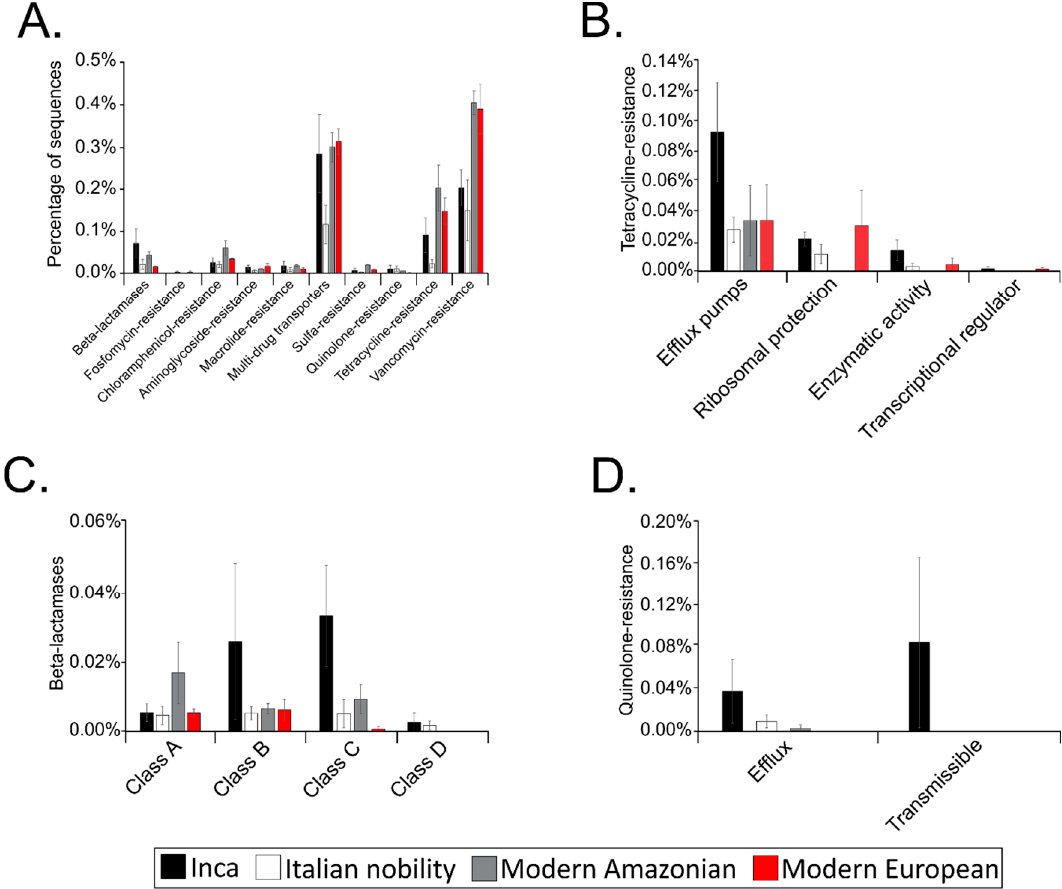
Figure 5. Putative resistome profiles of the pre-Inca/Inca and Italian nobility mummies. ( A ) Percentage of sequences similar to genes encoding for putative β -lactamases, multidrug transporters and resistance to fosfomycin, chloramphenicol, aminoglycoside, macrolide, sulfa, quinolone, tetracycline and vancomycin. ( B ) Putative tetracycline resistome showing the percentage of sequences similar to genes encoding for efflux pumps, ribosomal protection proteins, proteins with enzymatic activity and transcriptional regulators. ( C ) Putative β -lactamase resistome showing the percentage of sequences similar to genes encoding for Class A, Class B, Class C, and Class D β -lactamases. ( D ) Putative quinolone resistome showing the percentage of sequences similar to genes encoding for efflux pumps and those that are transmissible. Results were also compared to modern Amazonians and modern Europeans.